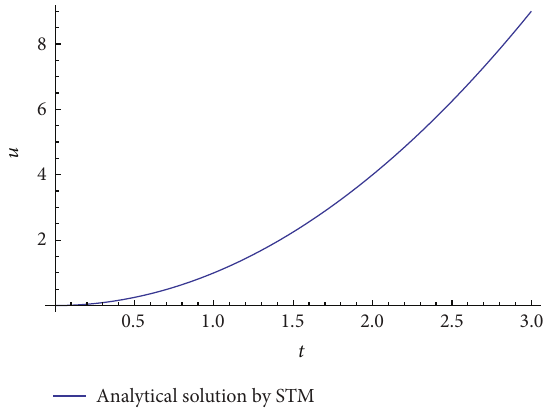
Figure 2: The 2D surfaces of the obtained solution by means of STM for (27) when 0 < 𝑡 < 3